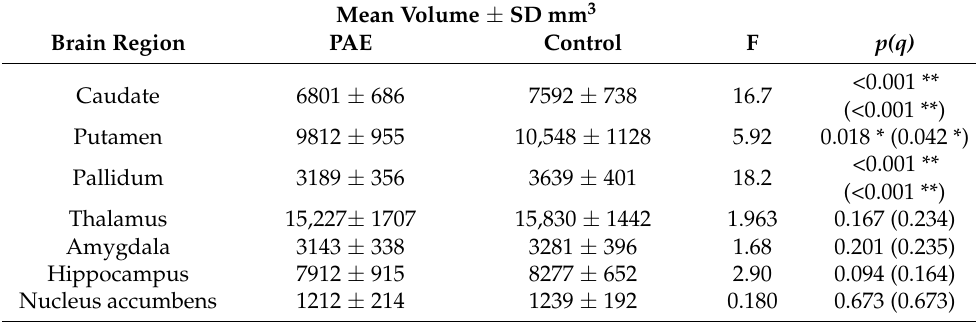
Table 3. Group differences in volume between PAE and unexposed control participants by region of